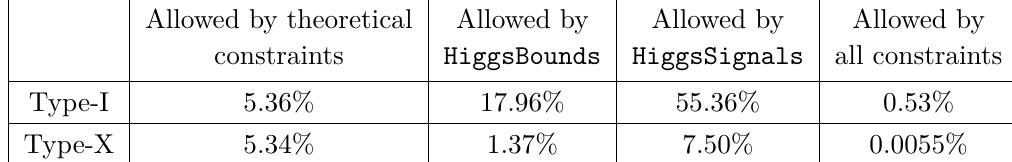
Table 4 . Details of the allowed points in parameter space after imposing theoretical and exper- imental constraints. Note that EWPO and flavour constraints are essentially always satisfied in both 2HDM Types. Here, we have used a dataset with 5 × 10 6 sample